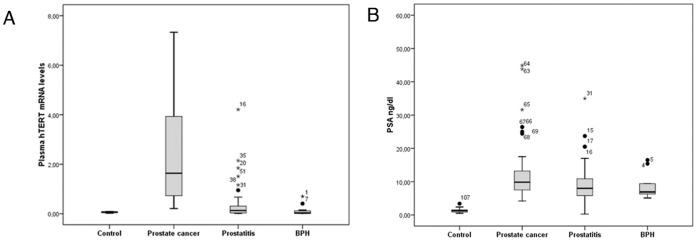
Boxplot diagram showing hTERT mRNA, serum PSA levels and histopathological findings.Data are expressed as median and interquartile range. A) Quantification of plasma hTERT mRNA levels discriminates between PCa patients and healthy individuals (p<0.001). B) Although PSA levels were significantly higher in PCa patients than in controls (p<0.001), quantification of serum PSA was unable to discriminate between PCa, BPH and prostatitis patients. BPH = Benign Prostatic Hyperplasia.